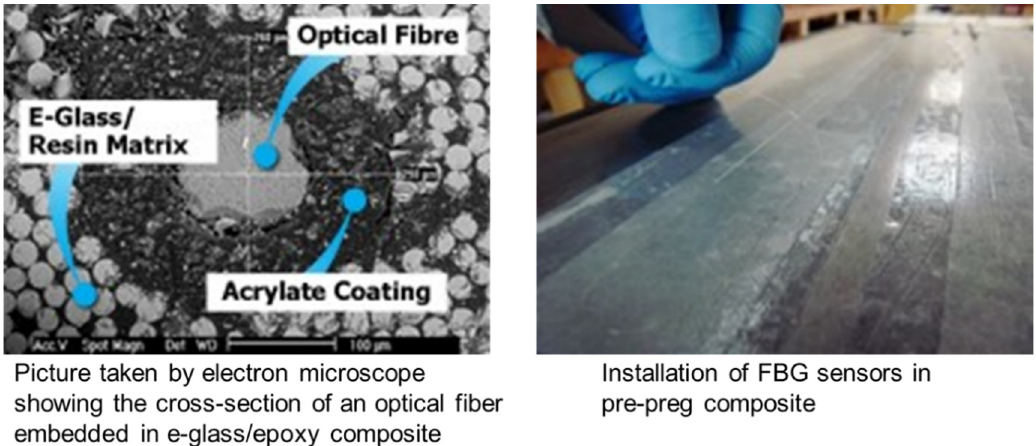
Figure 3. Embedded sensor (courtesy: Epsilon Optics).